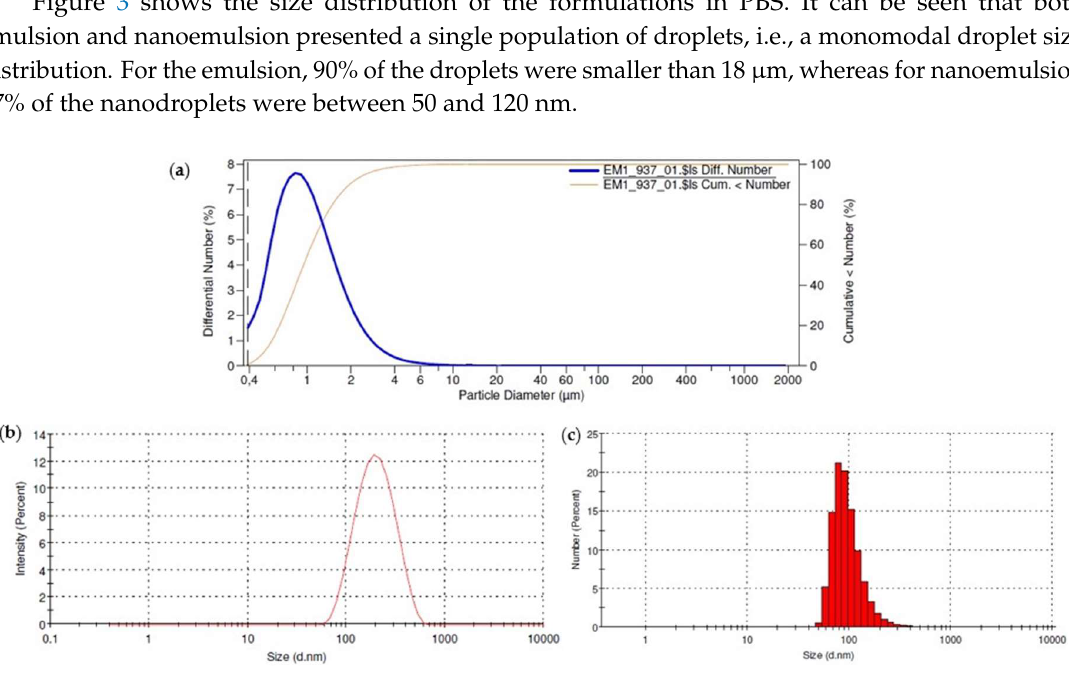
Figure 3. Size distribution of ( a ) ZnPc emulsion ( b ) ZnPc nanoemulsion by intensity and ( c ) ZnPc nanoemulsion by number.